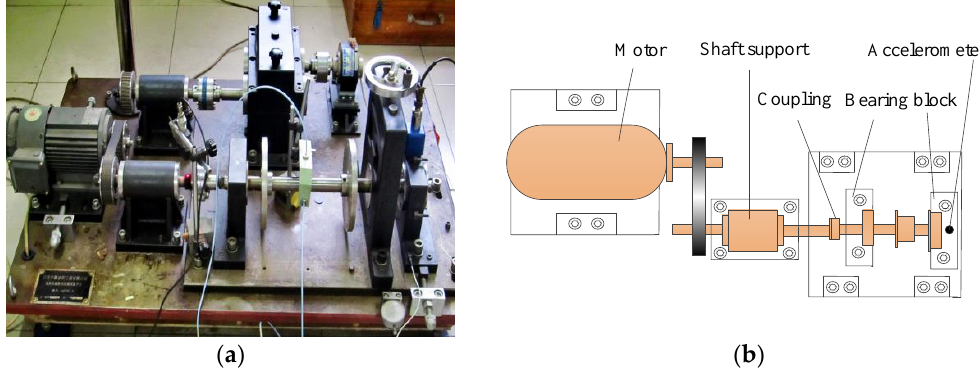
Figure 6. ( a ) The experiment rig; ( b ) its structure diagram.